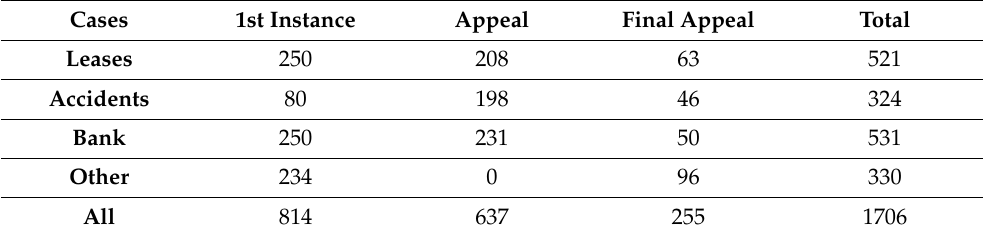
Table 2. Cases breakdown by degree and law